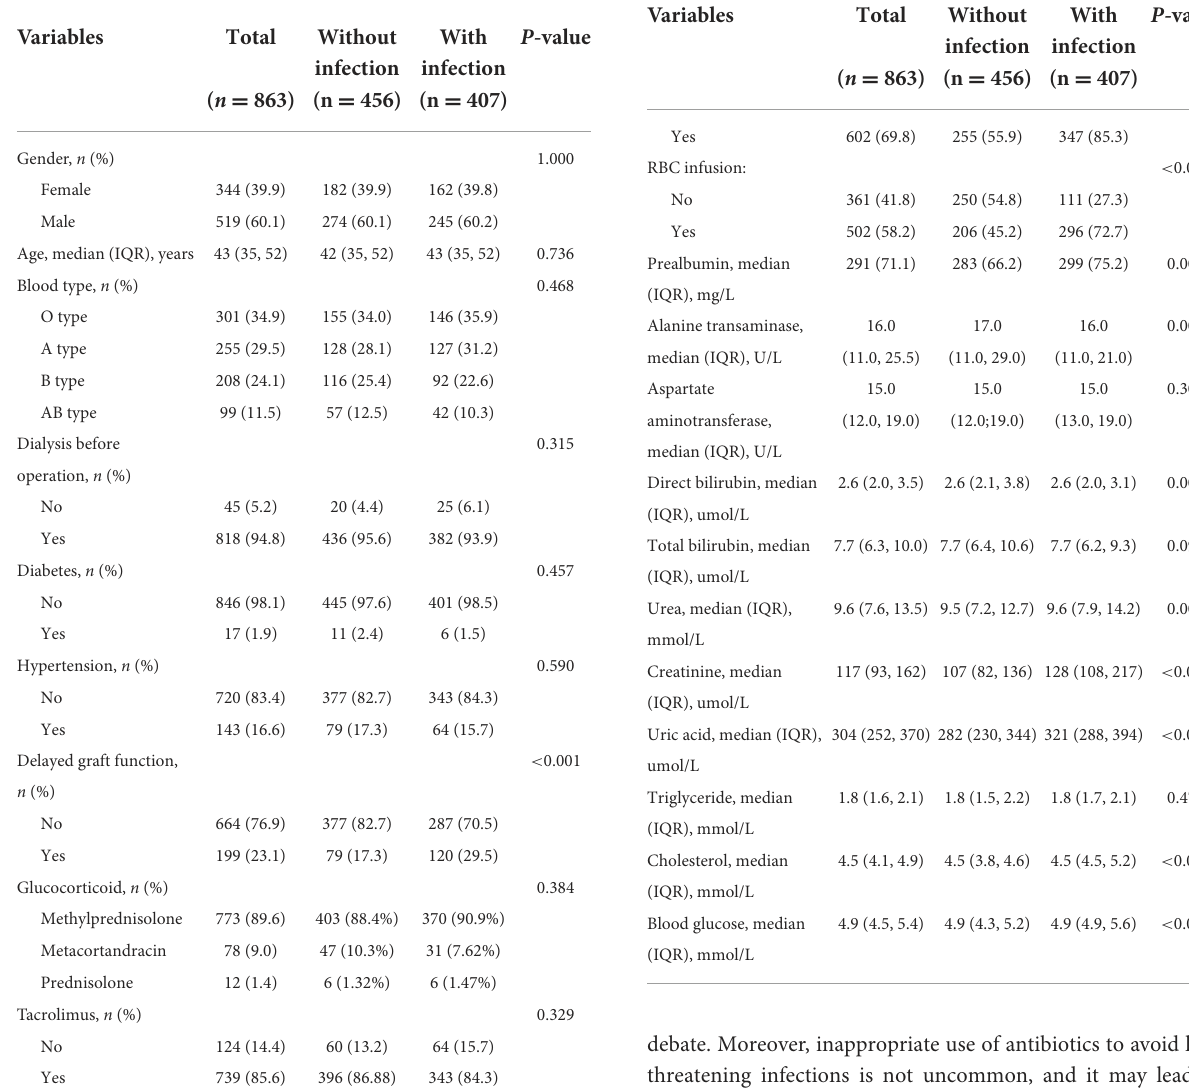
TABLE 1 Demographics and clinical characteristics of patients with or without infectious